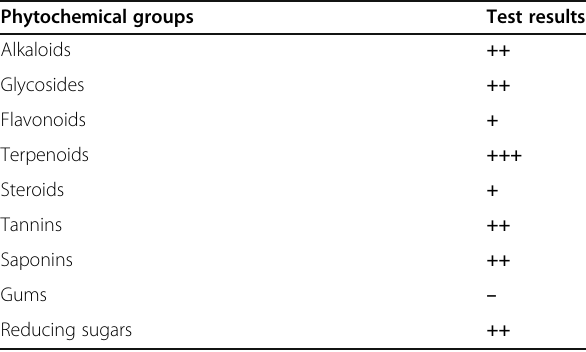
Table 1 Secondary metabolites in B. pilosa ethanol extract Phytochemical